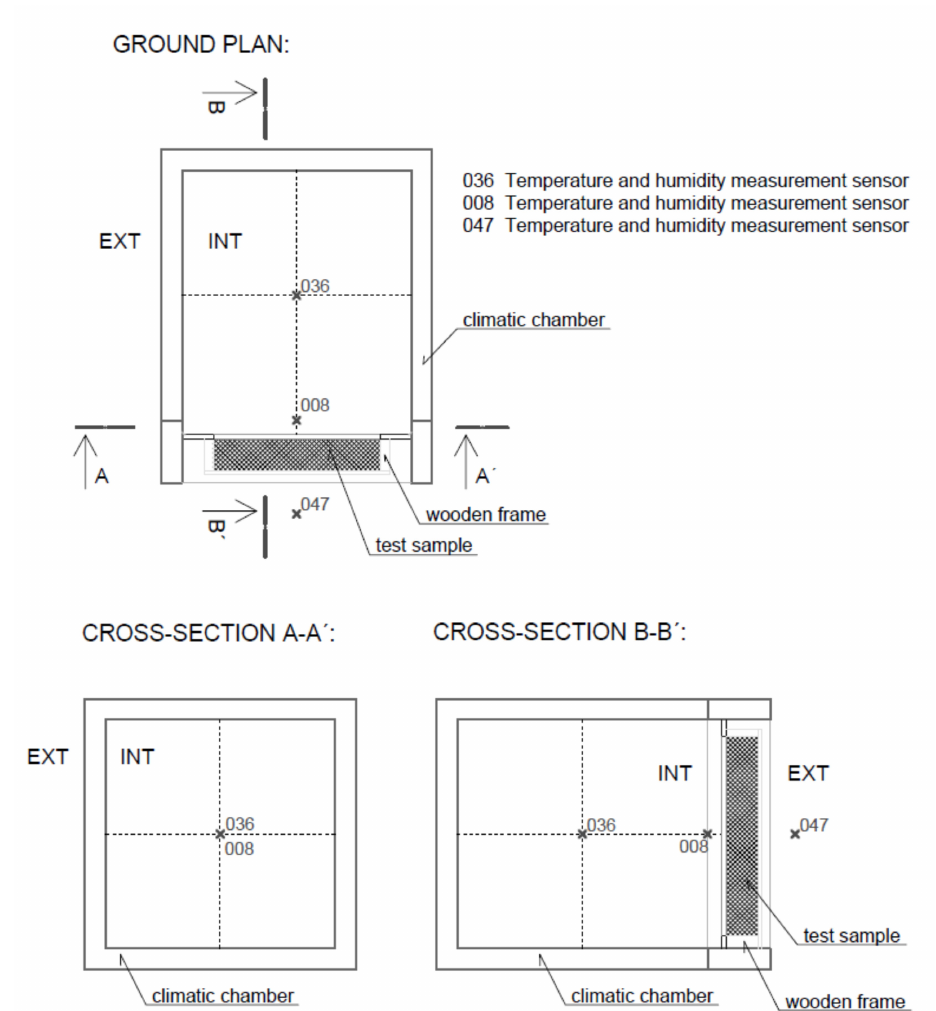
Figure 1. Diagram of the instrumentation scheme: climatic chamber; test sample; location of the sensors.